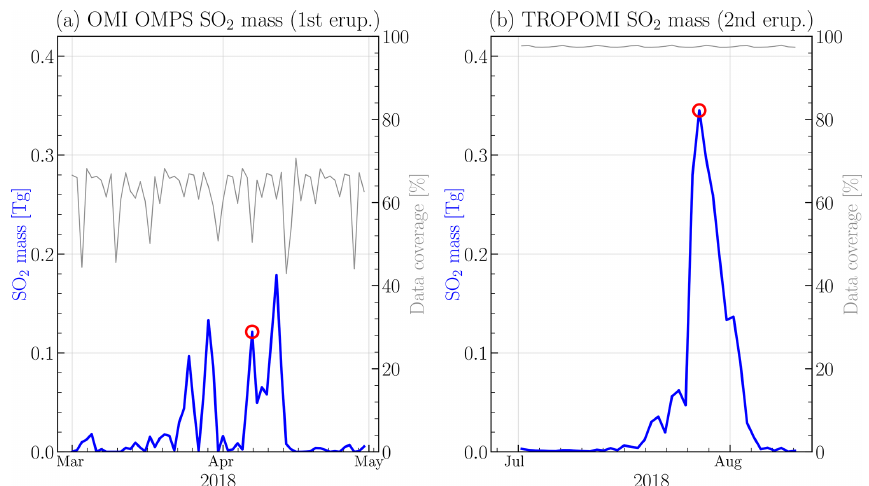
Figure 1. The SO 2 mass calculated for a threshold of 0.05gm − 2 from the combined OMI and OMPS-NM for the first Ambae eruption in April (a) and from TROPOMI data for the July eruption (b)